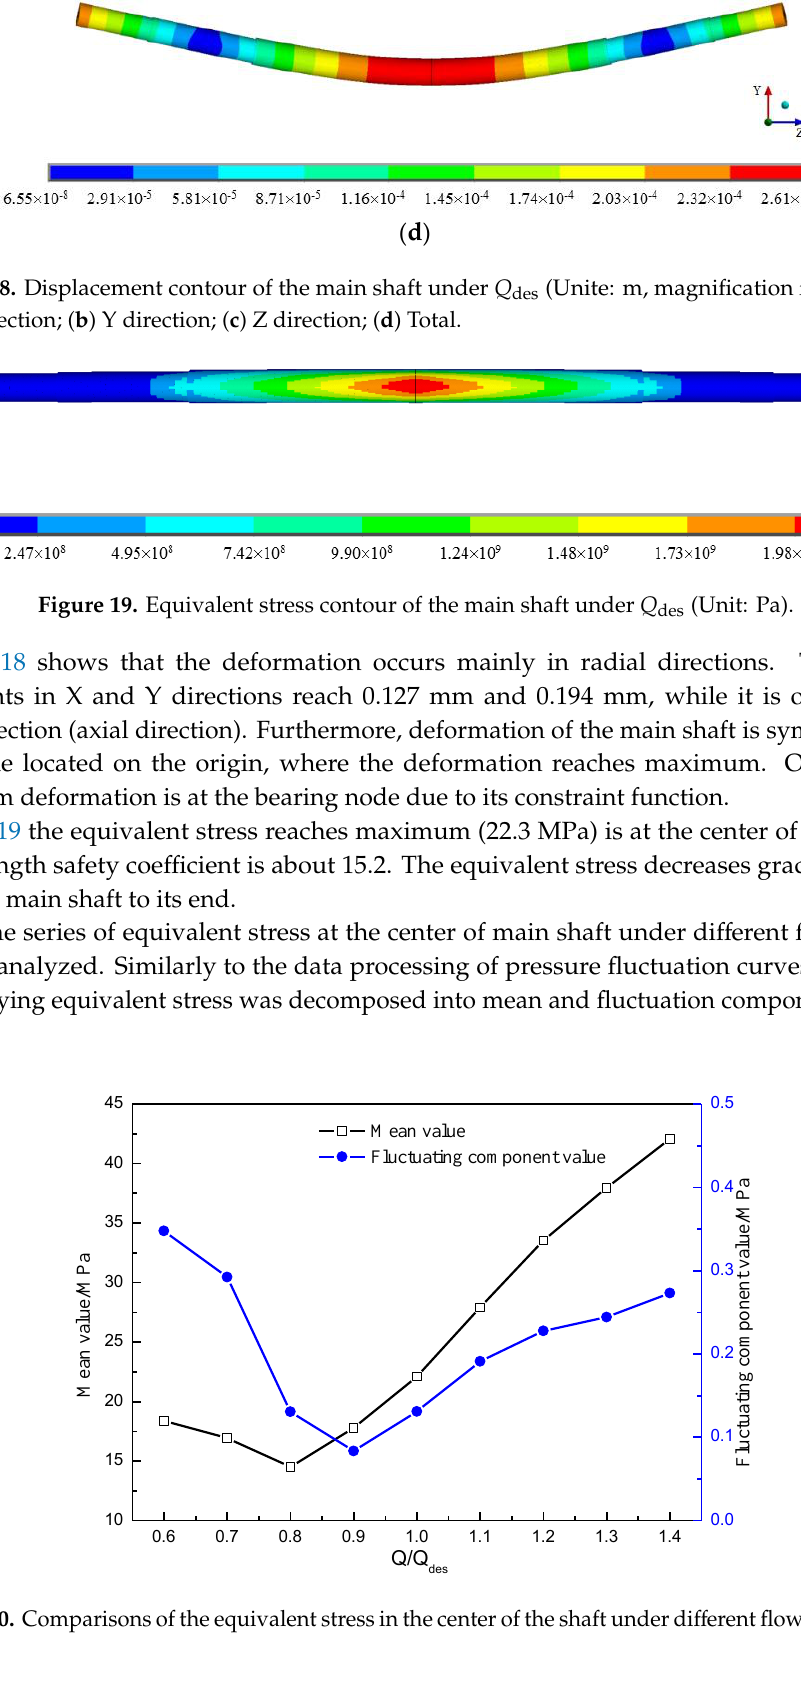
Figure 18. Displacement contour of the main shaft under Q des (Unite: m, magnification factor: 250): ( a ) X direction; ( b ) Y direction; ( c ) Z direction; ( d ) Total.